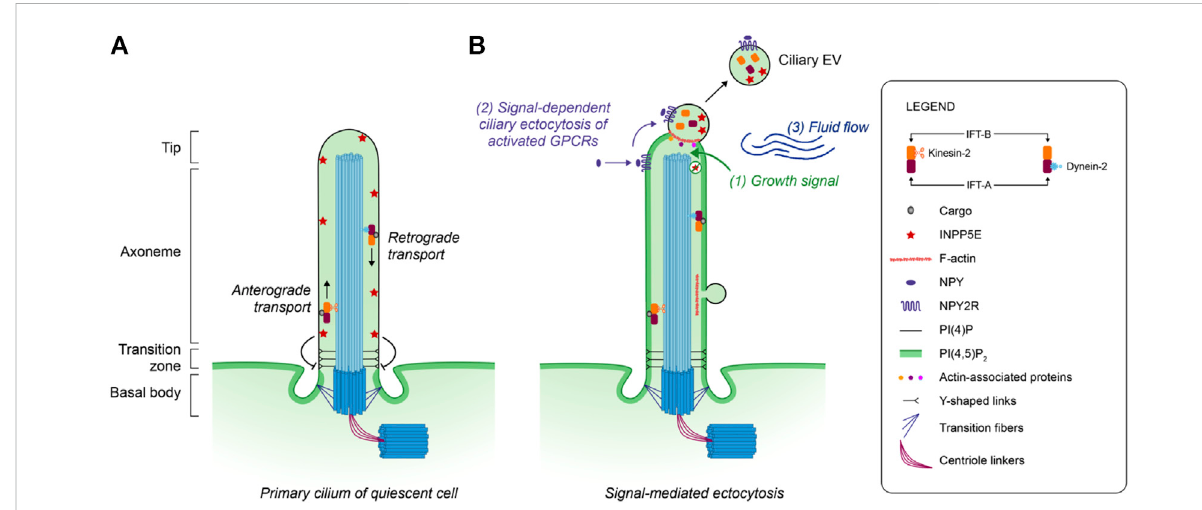
FIGURE 1 Model of ectocytosis from the mammal primary cilium. (A) The intra fl agellar transport system (IFT) participates in the assembly and maintenance of the primary cilium through the transport of molecular cargos by IFT-A and IFT-B protein complexes. In quiescent cells, the primary ciliary membrane is enriched in PI(4)P due to the presence of the ciliary phosphatase INPP5E which converts PI(4,5)P2 to PI(4)P. (B) Following a proliferation growth signal (1), the ciliary phosphatase INPP5E is removed from the membrane, promoting the redistribution of the phosphoinositide PI(4,5)P 2 in the primary cilium. These membrane changes allow the local polymerization of F-actin through the recruitment of actin-associated proteins, followed by the ectocytosis of ciliary EVs enriched in bioactive molecules. Although ectocytosis following actin polymerization was identi fi ed at the cilium tip, F-actin was also observed in the vicinity of ciliary EVs present along the axoneme membrane. The activatedNeuropeptideYreceptortype2(NPY2R)usesectocytosisas aconstitutivewayto exitthecilium (2).Themechanicalforce(3)generatedby the surrounding fl uid fl ow also promotes the release of ciliary